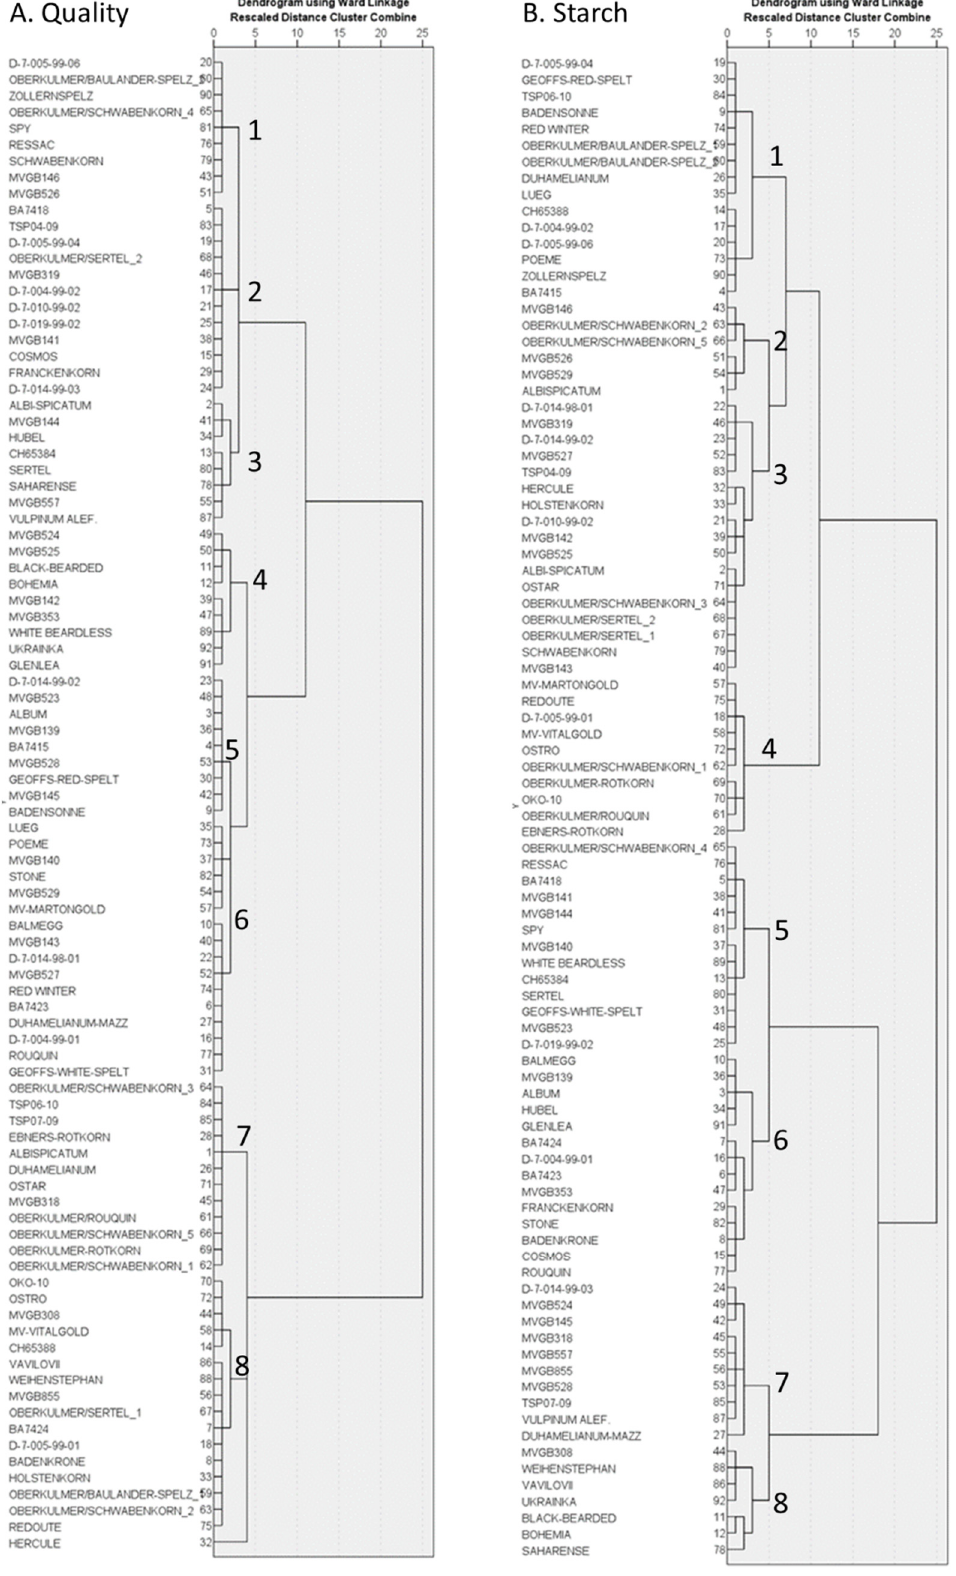
Figure 2. Hierarchical cluster analysis based on the quality traits ( A ) and the starch properties ( B ) of the flour of 90 spelt genotypes examined in Hungary (Martonvásár, 2017–2019).